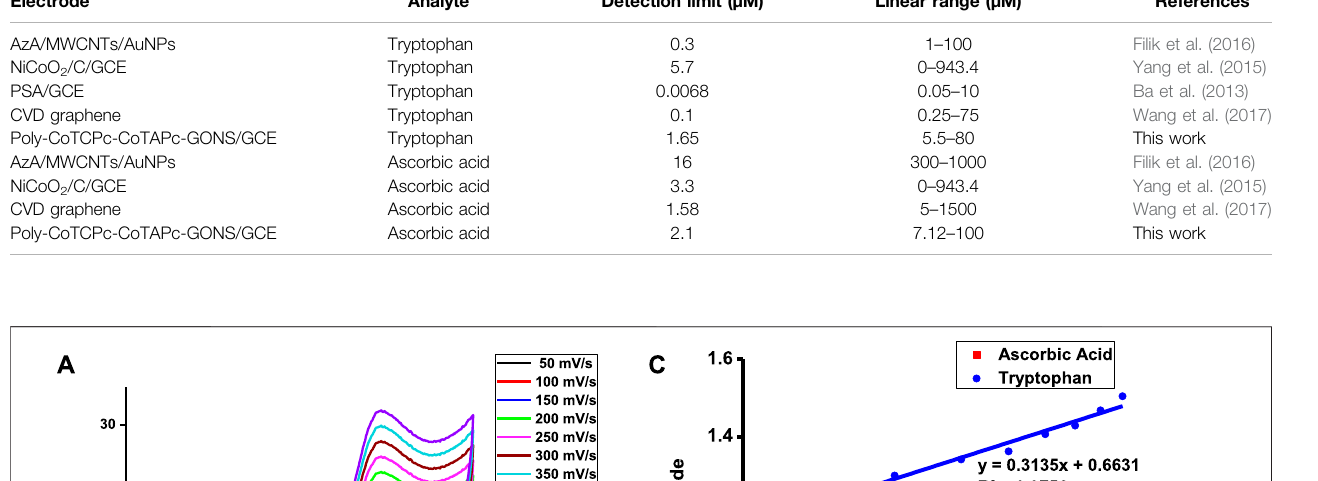
TABLE 1 | Comparison of performance of poly-CoTCPc-CoTAPc-GONS/GCE with other electrodes reported in the literature.